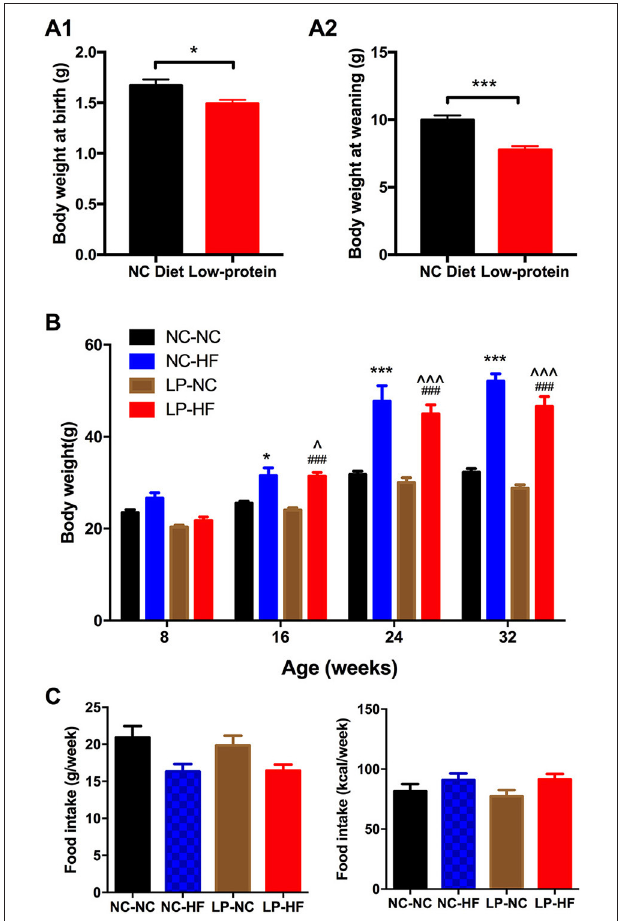
FIGURE 1 | Effects of maternal protein restriction and post-weaning high-fat feeding on body weight and food intake in offspring. (A) Birth weight; (B) body weight at weaning; (C) body weight from 8 to 32 weeks of age. Data were represented as mean ± SEM ( n = 6–8/group). * P < 0.05, *** P <